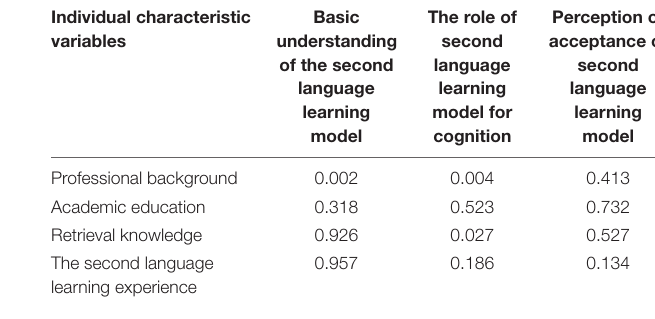
TABLE 2 | Variance test of the impact of second language learning knowledge and experience on the cognitive impact of the second language learning model of Chinese students in the post-epidemic